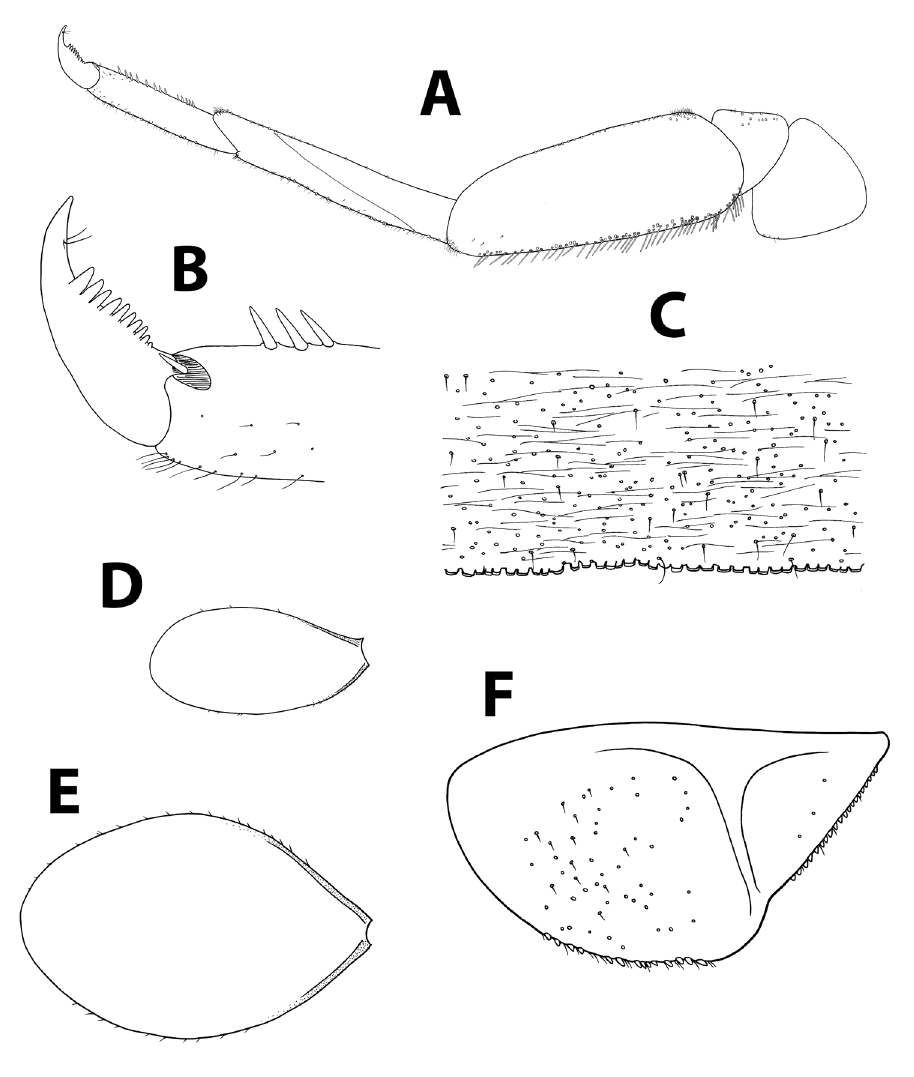
Figure 15. Baetis pacis sp. n., nymph. A foreleg B tarsal claw C abdominal tergum V, surface and distal margin D gill I E gill IV F paraproct